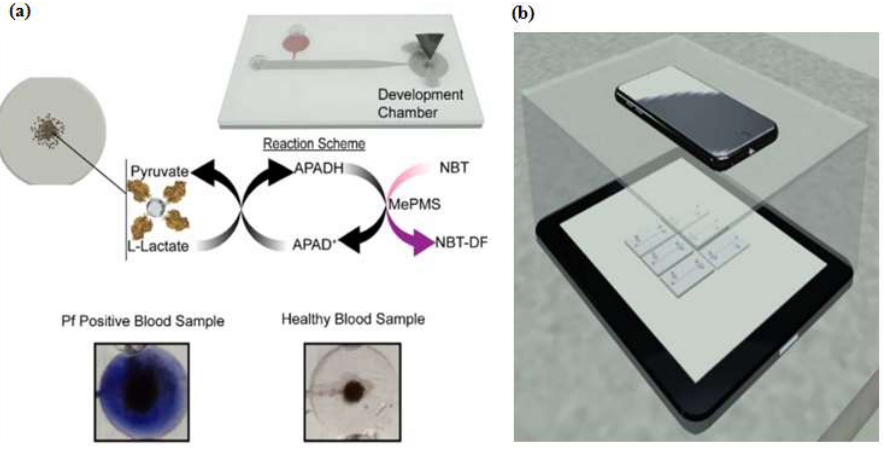
Figure 9. Microfluidic Aptamer-Tethered Enzyme Capture (APTEC) biosensor. ( a ) The reaction scheme of the reagents and redox reaction that results in the generation of an insoluble purple diformazan dye. There was a color difference between positive and negative samples; ( b ) The smartphone camera was used for capturing images in a telemedicine application. Reproduced with permission from reference [97]. Copyright 2018 Elsevier.